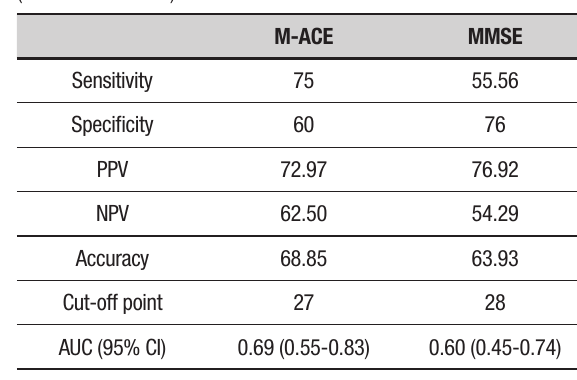
Table 3. Sensitivity, specificity, PPV, NPV of the M-ACE versus MMSE (control versus MCI).